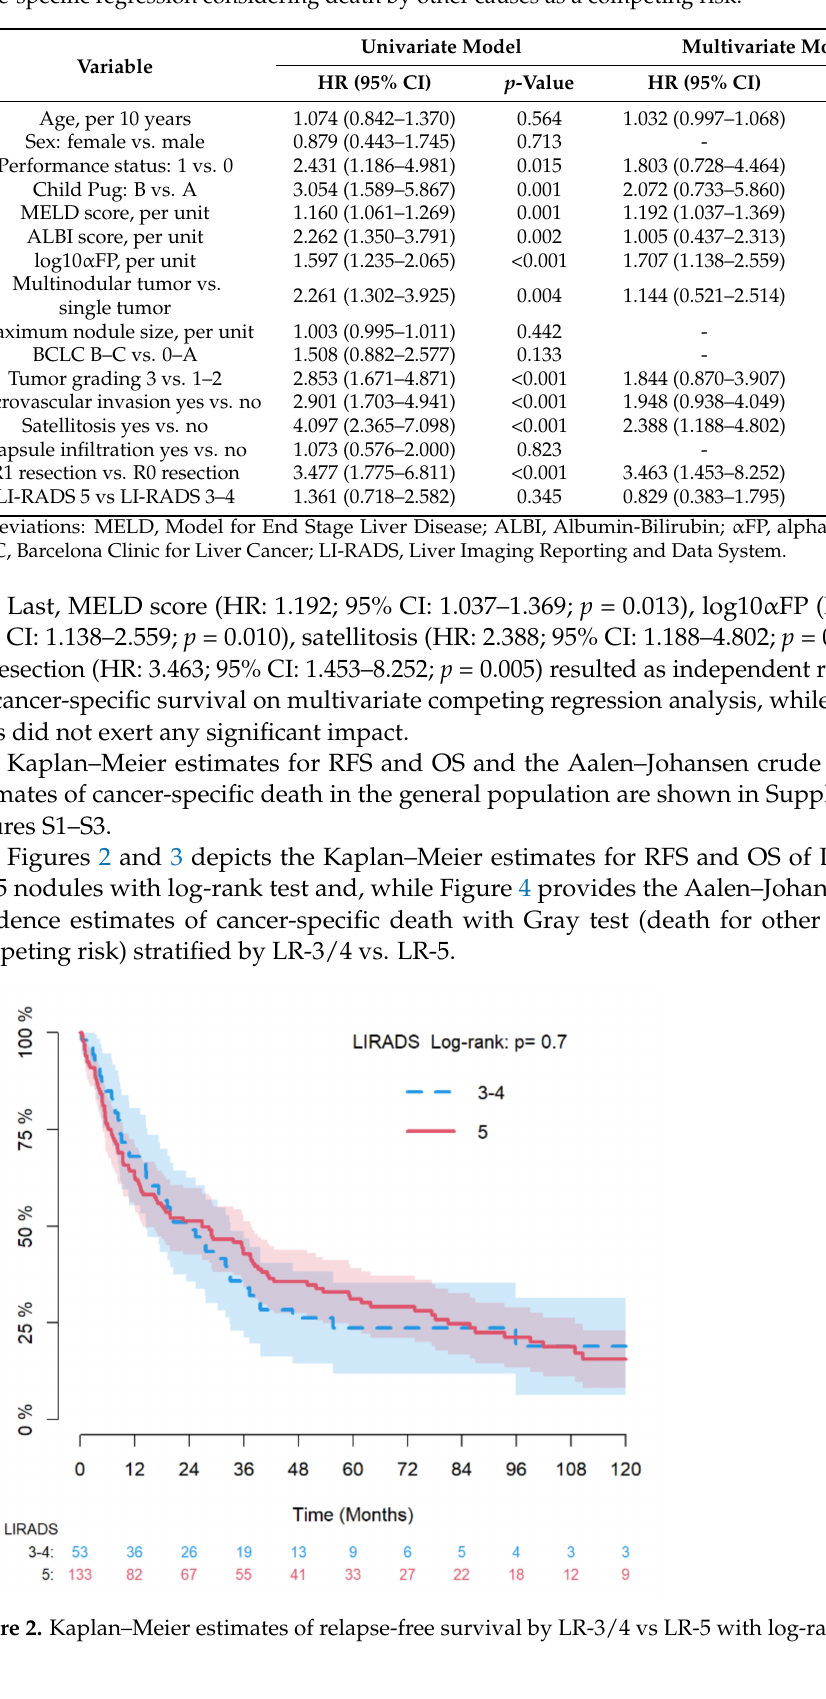
Table 5. Univariate and multivariate association of risk factors with cancer-specific death by Cox cause-specific regression considering death by other causes as a competing risk.